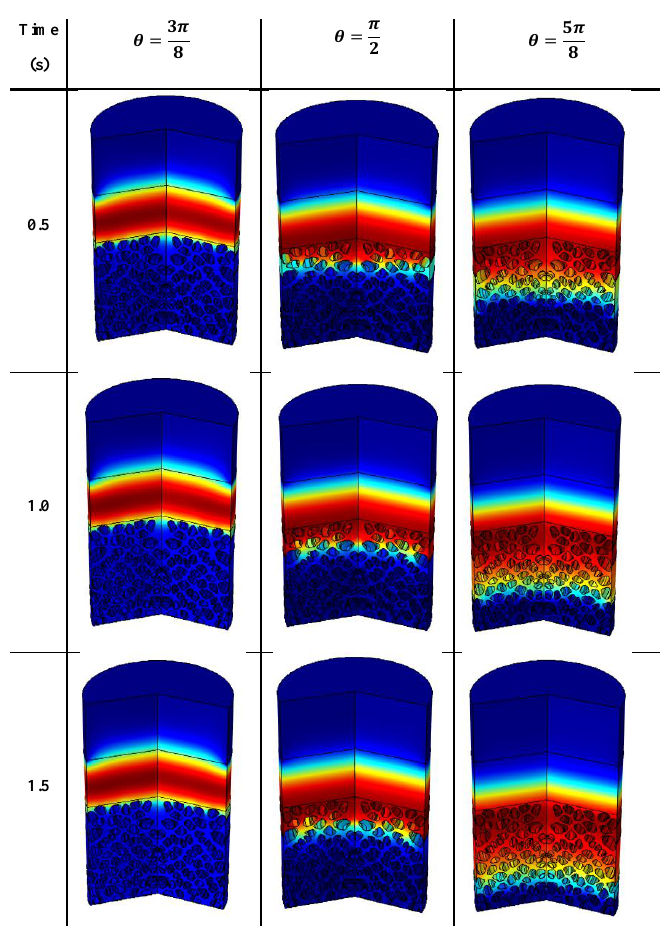
Figure 6. Snapshots of the penetration of a cement paste through a sand bed with particles of d agg = 1.6 mm: influence of the value of the contact angle.